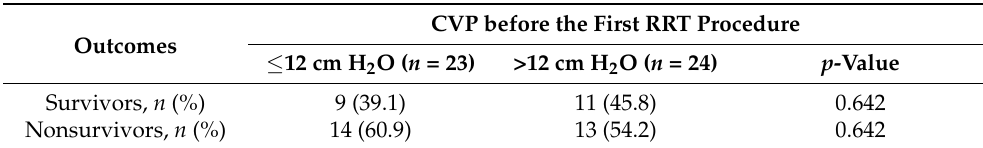
Table 3. The outcomes of the patients in different groups according to CVP.